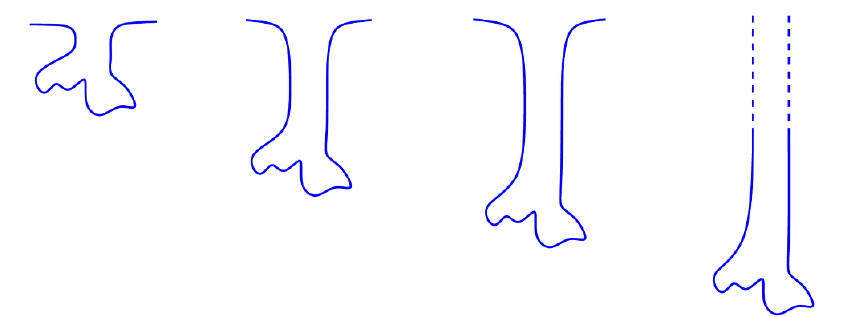
Figure 1 . A schematic pictorial representation of a scaling geometry and the asymptotically AdS 2 limit. The proper size of the bubbles remains the same as the throat of the solutions becomes longer [26, 27]; the throat becomes in(cid:12)nite in the AdS 2